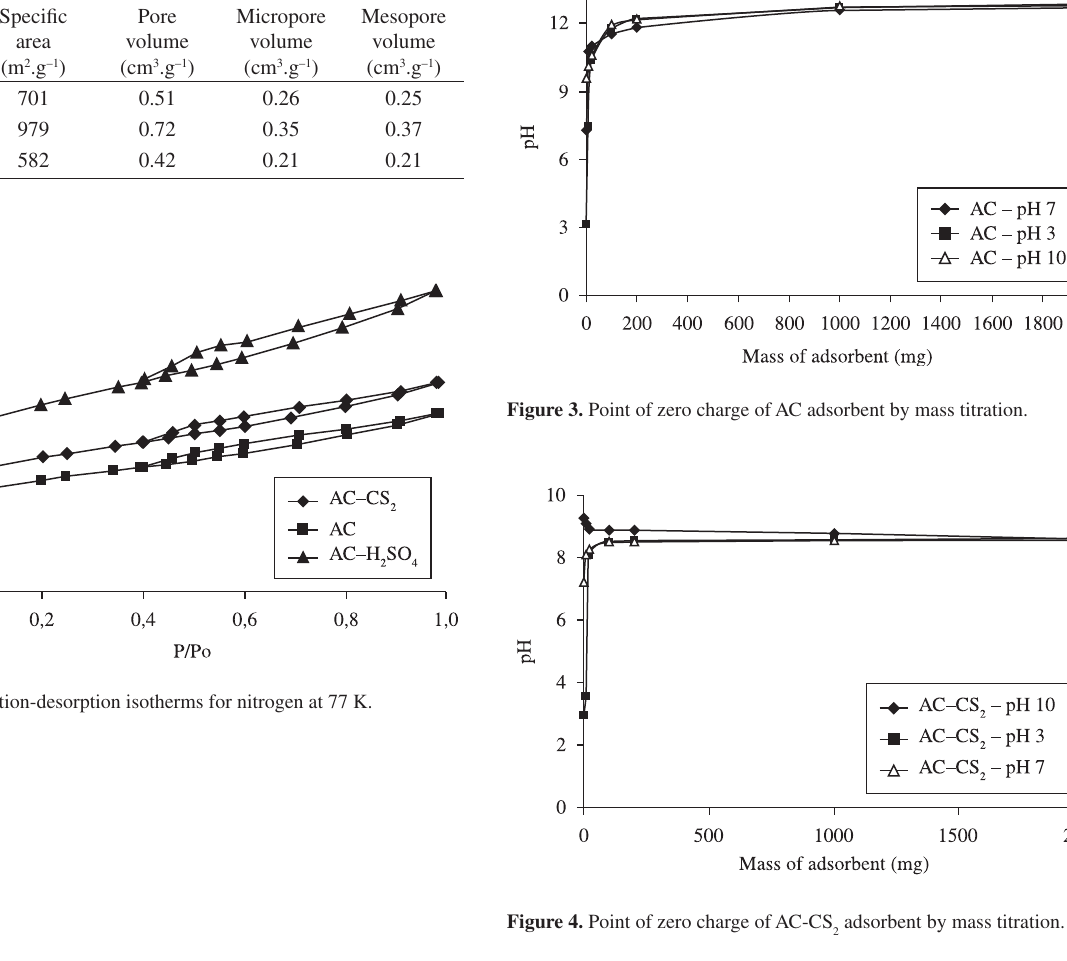
adsorbent by mass titration. 2